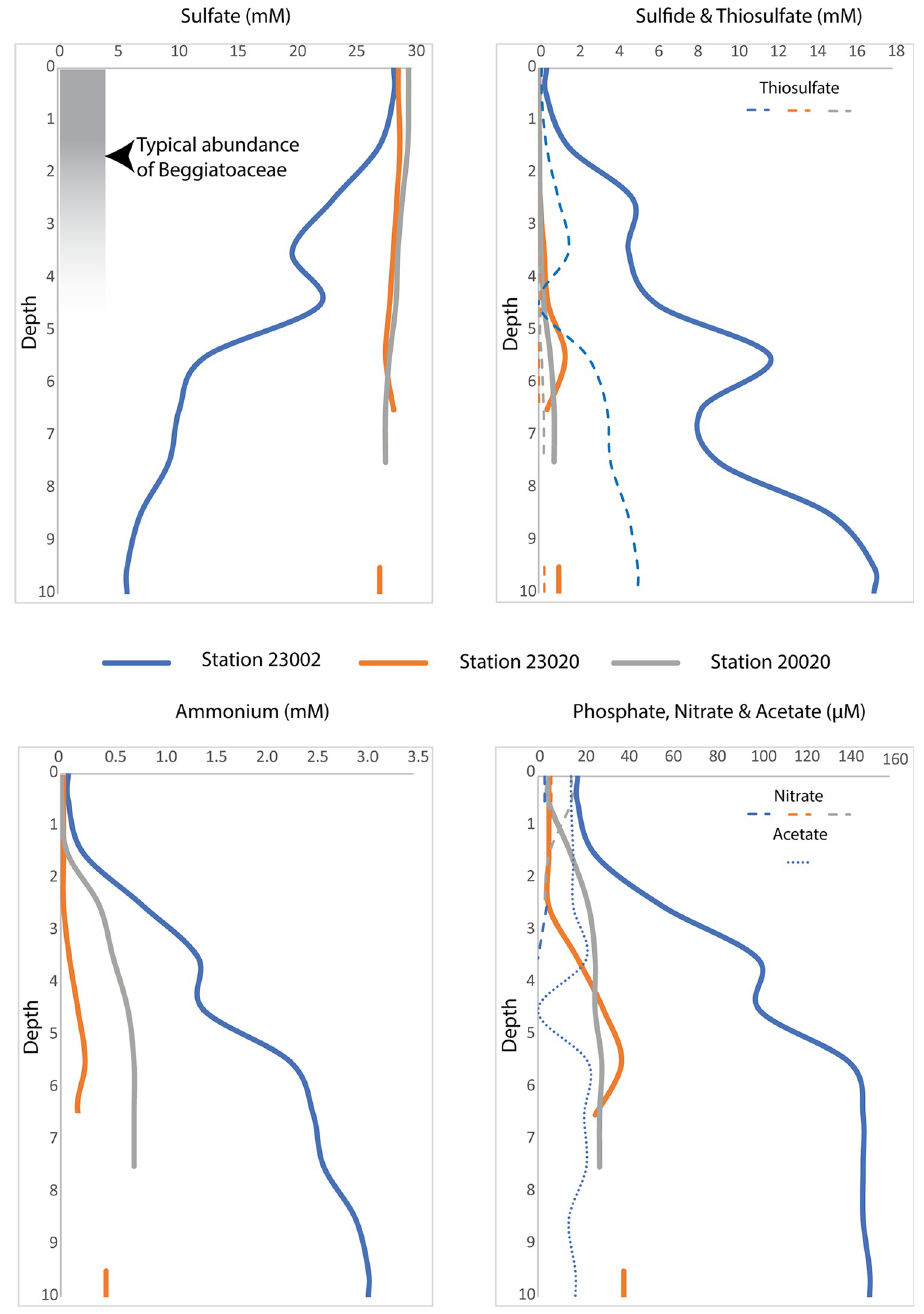
Fig 3. Geochemical profiles for the top 10 cm of sediment core porewaters with general zonation of Beggiatoaceae. Porewaters were collected from marine stations 23002 (blue; 1–10 cm), 23020 (orange; 1–7, 9–10 cm) and 20020 (grey; 1–7 cm). Formate ( < 11 μ M) and nitrite ( < 2 μ M) and other data points not shown for analyzed 1cm horizons were below detection limits. Standard deviations were low and representative crossbars were not visible on